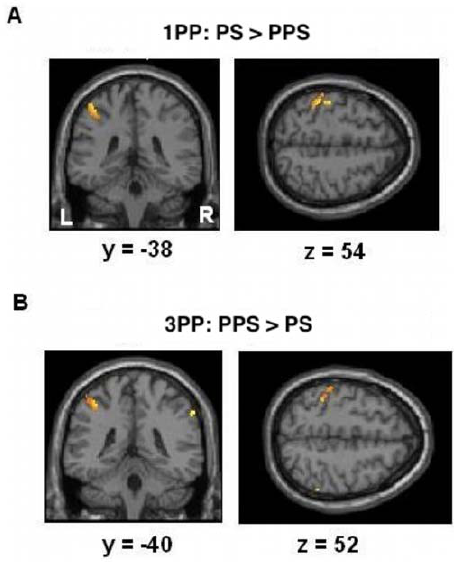
Figure 2. Results of experiment 1. Statistical maps showing overlapping activation (p , 0.05, FWE corrected) for visual conditions (PS/PPS) and real touch. A: Brain activation in left SI for touch hand relative to movements in peripersonal space video clips in 1PP. B: The analogue contrast in 3PP shows no significant overlap. In contrast, the test movements in peripersonal space relative to touch hand